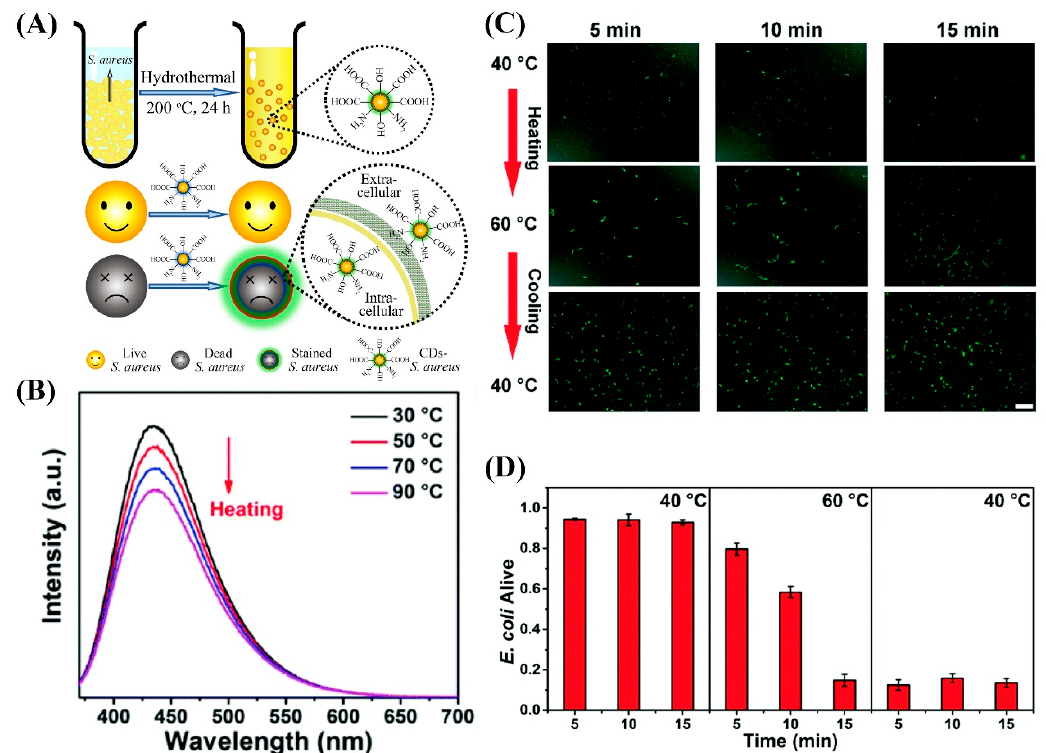
Figure 4. ( A ) Schematic of preparation and selective dead bacterial staining of CDs- S. aureus . Reproduced with permission from [23]. Copyright Royal Society of Chemistry, 2017. ( B ) Fluorescence spectra of nitrogen, phosphorus, and sulfur co-doped CDs (NPSCDs) under heating. ( C ) Confocal images of E . coli cells under various conditions and ( D ) corresponding rates of live E . coli in ( C ) with three replicates. The figures in ( B – D ) are reproduced with permission from [57]. Copyright Royal Society of Chemistry, 2017.